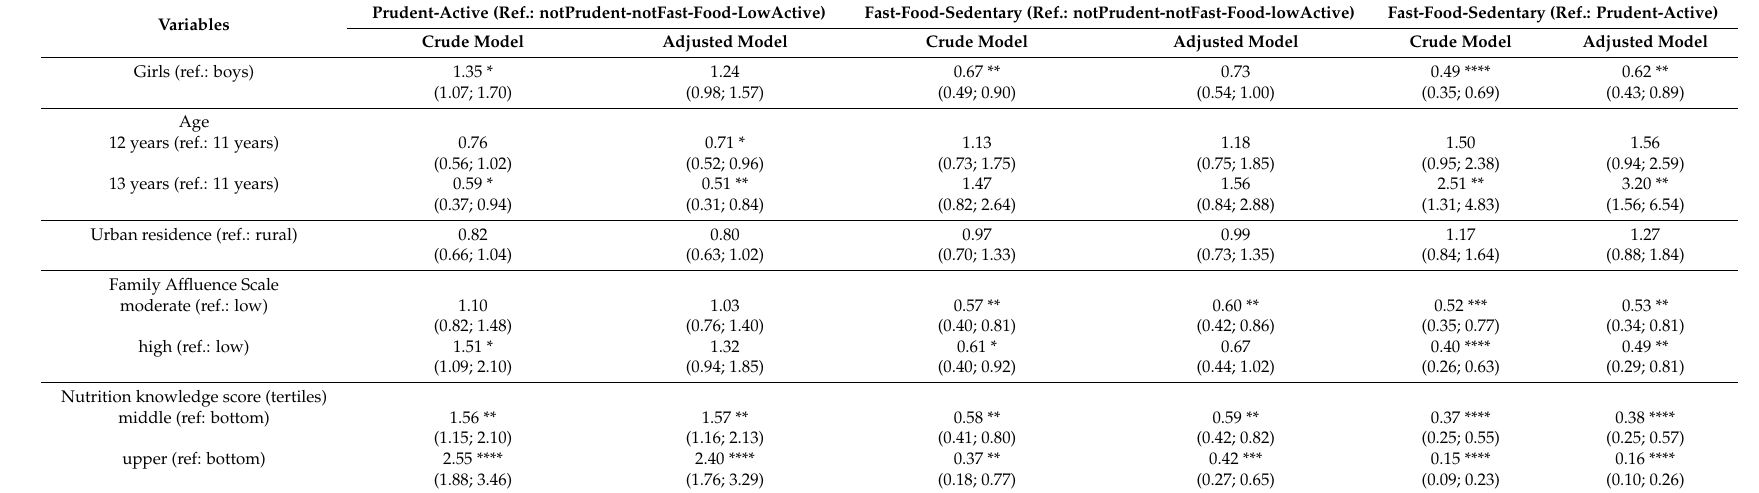
Table 2. Odds ratios (95% confidence interval) for dietary-lifestyle patterns by sociodemographic factors and nutrition knowledge.